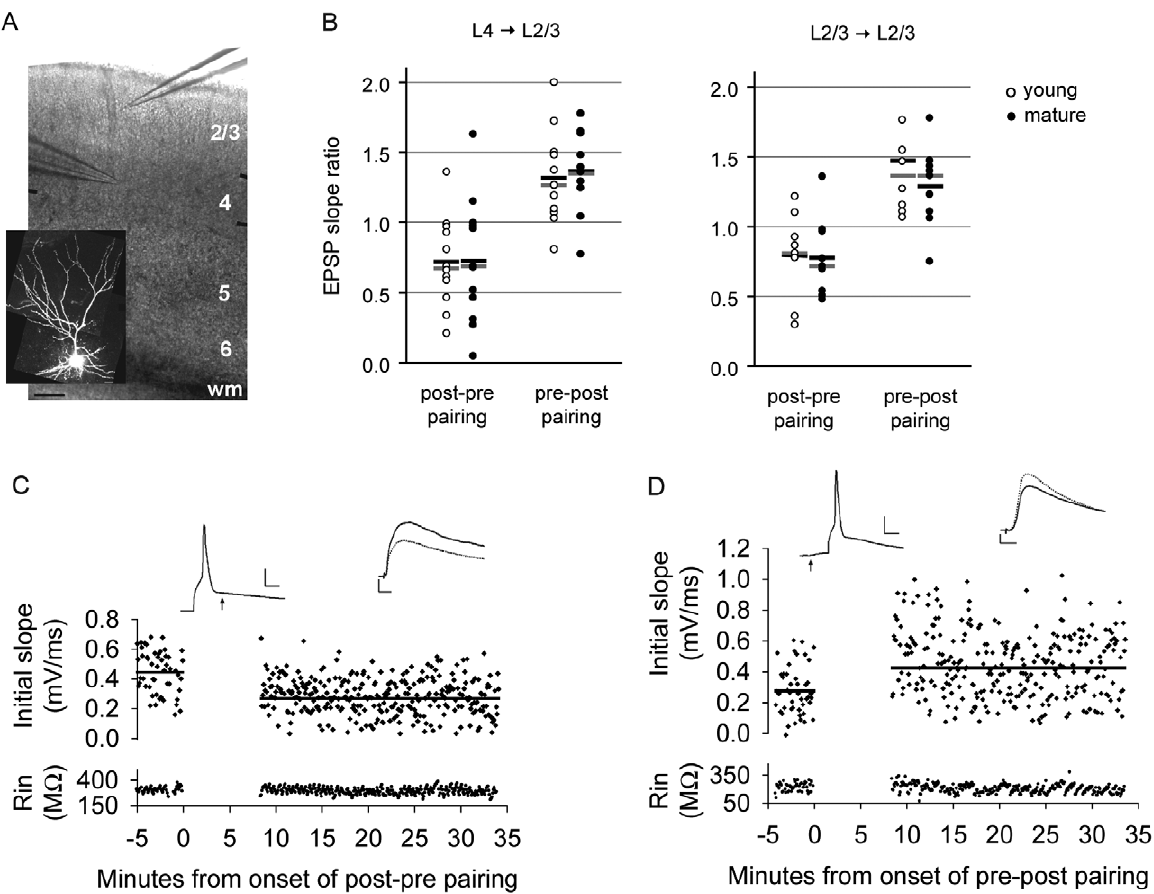
Figure 1. STDP is inducible in mouse primary visual cortex before and after the onset of the critical period of OD plasticity. (A) Position of field stimulation electrode in layer 4 and whole-cell recording electrode in layer 2/3 in V1, scale bar: 100 microns. WM: white matter. Inset: an alexa-594-filled L2/3 pyramidal neuron. (B) Mean (black bar) and median (gray bar) EPSP slope ratios for young (open circle, LTD n=12, LTP n=11) and mature (closed circle, LTD n=12, LTP n=11) age groups at vertical layer 4 R layer 2/3 connections (left) and layer 2/3 R 2/3 connections (right). (C) Example of an individual cell in which the EPSP followed the action potential by 9 ms, age=P17. (D) Example of an individual cell in which the EPSP preceded the action potential by 9 ms, age=P17, scale bar 25 mV, 5 ms. Baseline traces are represented by solid lines, post-pairing traces are represented by dashed lines, scale bar: 0.5 mV, 10 ms.